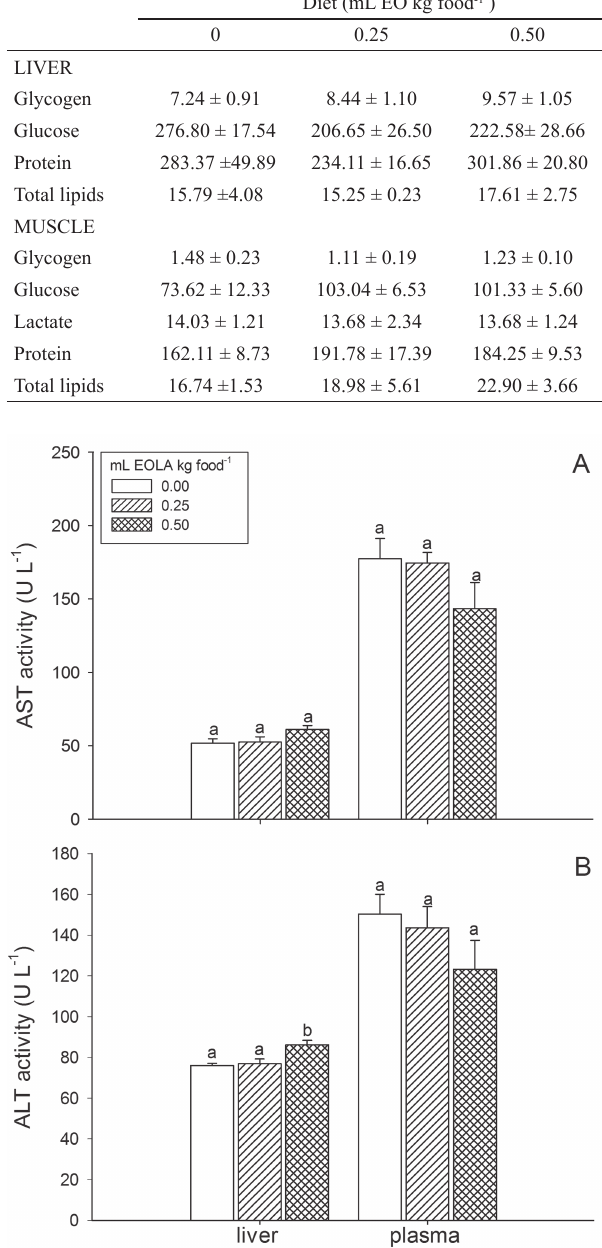
Table 2. Biochemical parameters in liver and muscle of Rhamdia quelen fed with diets containing different concentrations of the essential oil (EO) of Lippia alba .